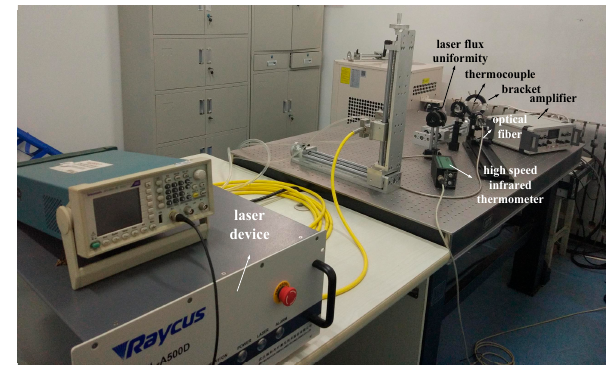
Figure 4. Experimental environment.